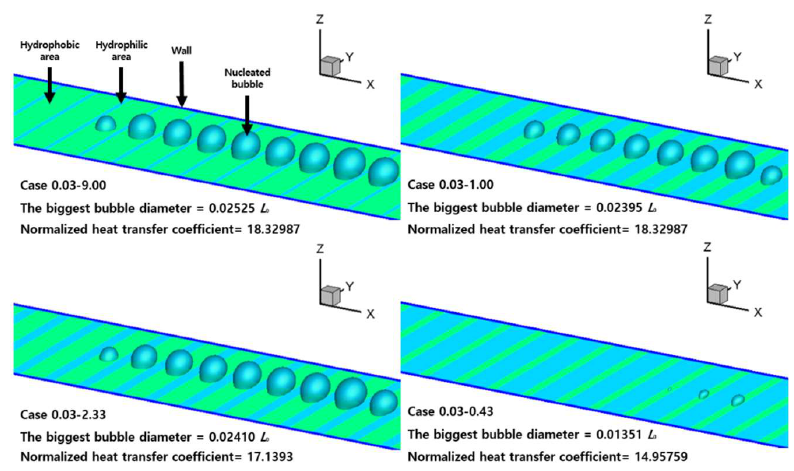
Figure 5. Comparison of bubble nucleation type and biggest bubble diameter according to pattern ratio. Time step = 30,000 and the pattern pitch is 0.03 L 0 .